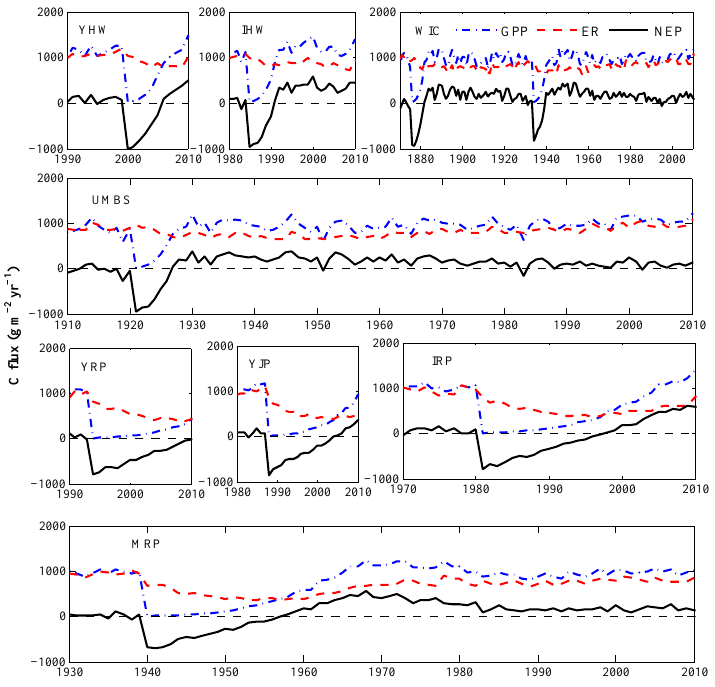
Figure 4. Simulated trajectories of GPP, ER, and NEP for each site based on the site disturbance history (Table 1). The time series started from the earliest major disturbance for each